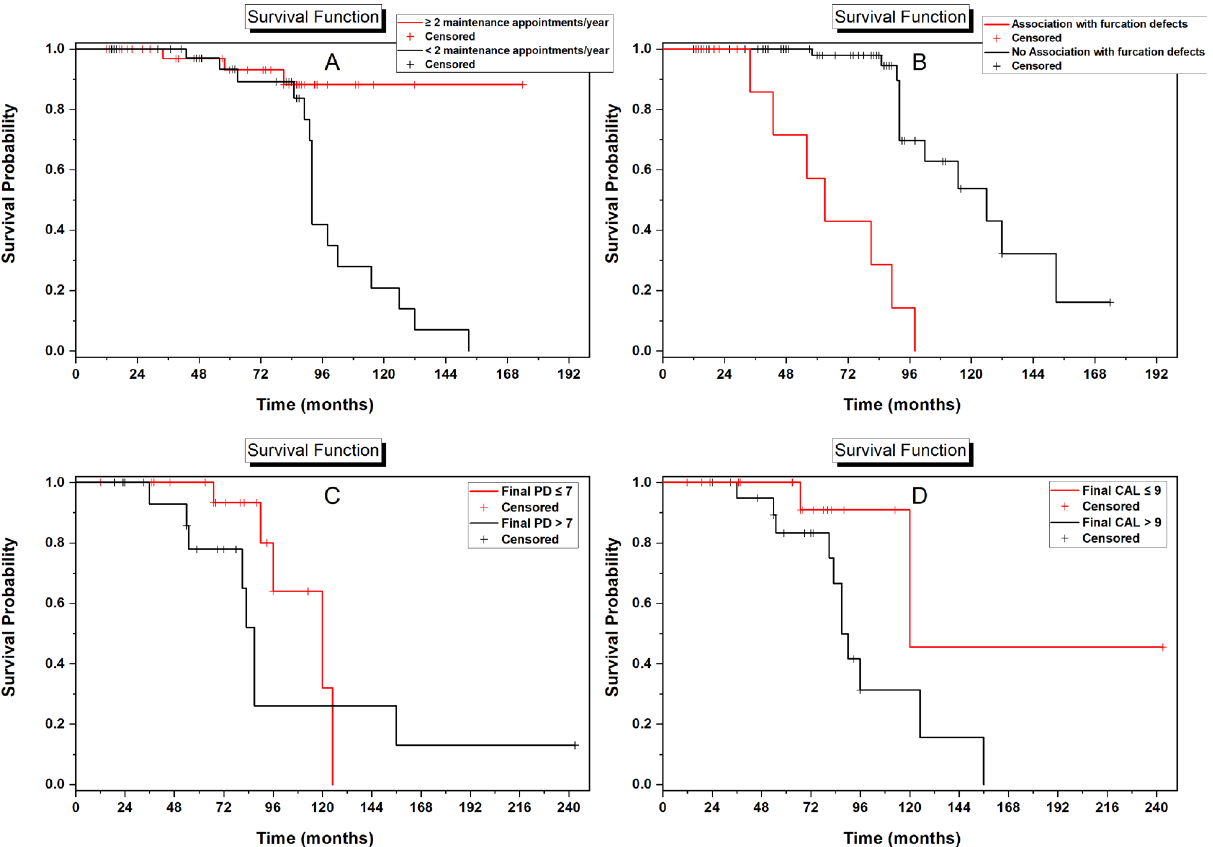
Figure 2. Kaplan–Meier survival curves displaying the comparison between: ( A ) teeth treated with SRP, receiving at least 2 maintenance appointments/year (red) and less than 2 maintenance appointments/year (black); ( B ) teeth treated with SRP, associated (red) versus not associated with furcation defects (black); ( C ) teeth treated with OFD, having at most 7 mm PD (red) and more than 7 mm PD (black) at the 3–6 months evaluation; and ( D ) teeth treated with OFD, having at most 9 mm CAL (red) and more than 9 mm CAL (black) at the 3–6 months evaluation. The median cut off value of PD and CAL were used when dichotomizing the stratifying variable. Event = Tooth